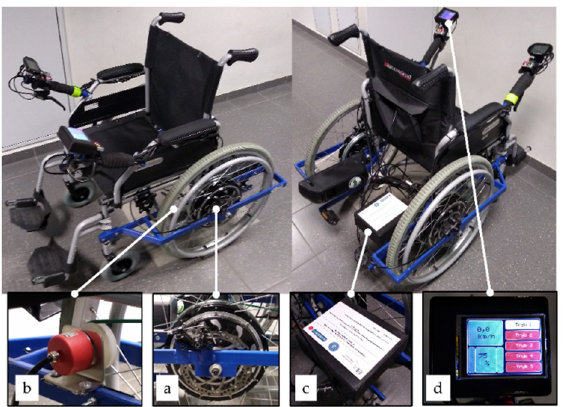
Figure 2. Tested AR-405 wheelchair equipped with a hybrid propulsion module. ( a ) BrushLess Direct-Current motor; ( b ) incremental encoder; ( c ) electronic controller; ( d ) touch screen.